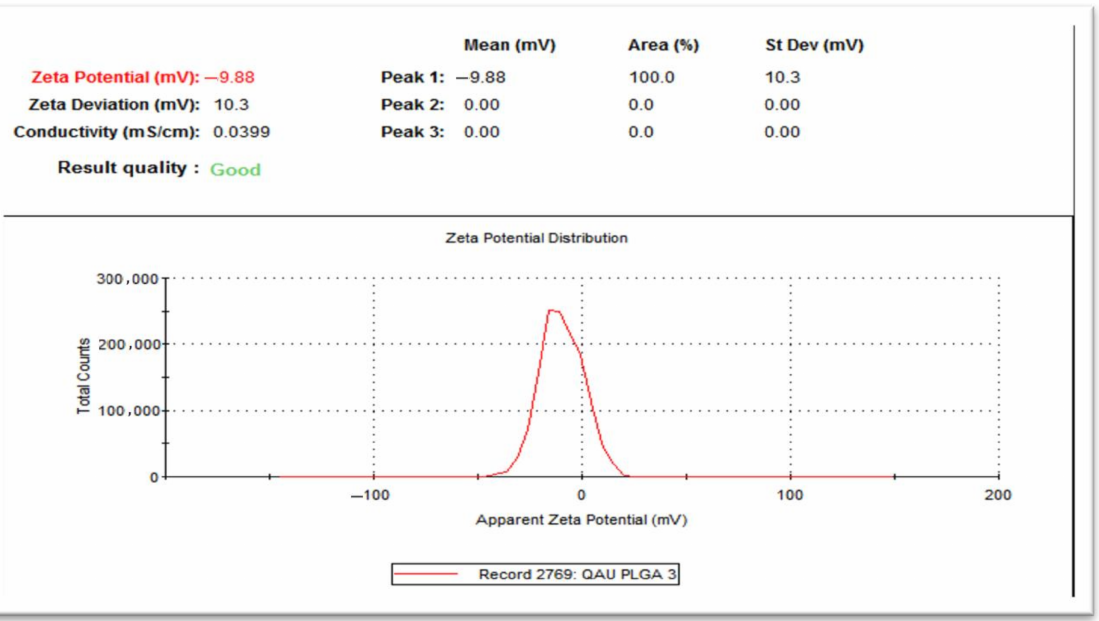
Figure 3. Zeta potential of the final PLGA nanoparticle